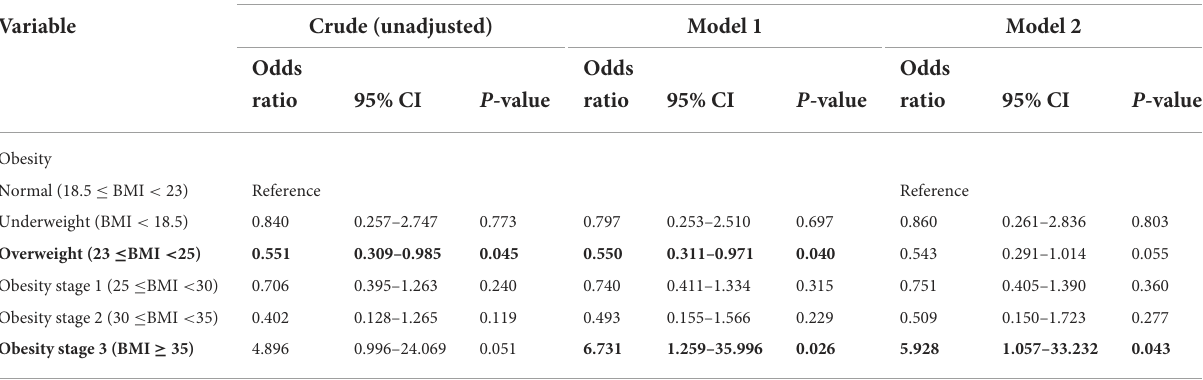
TABLE 6 Logistic regression analysis for balance problem with chronic dizziness according to the body mass